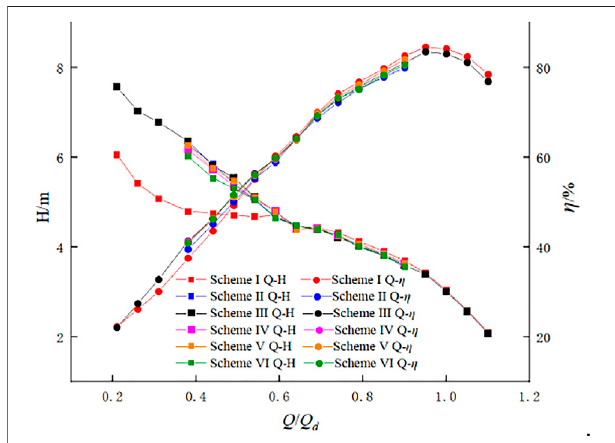
FIGURE 6 | Performance curves under different groove parameters.